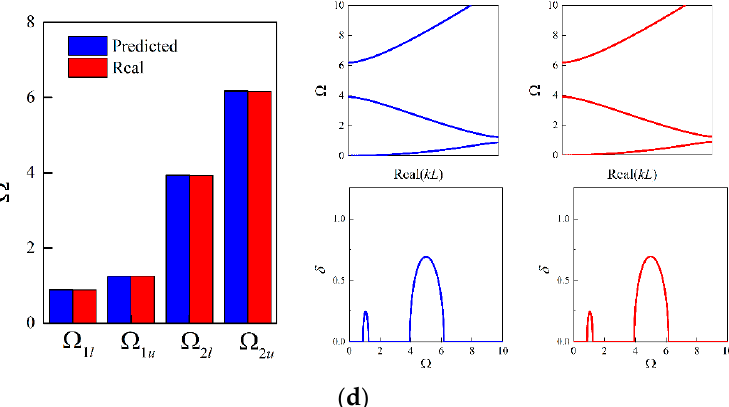
Figure 12. Comparison results of the bounding frequencies and complex dispersion curves between the generated parameters and real parameters for random examples: ( a ) example 1; ( b ) example 2; ( c ) example 3; ( d ) example 4. The blue lines denote the results based on generated values and the red lines denote that of ground truth.